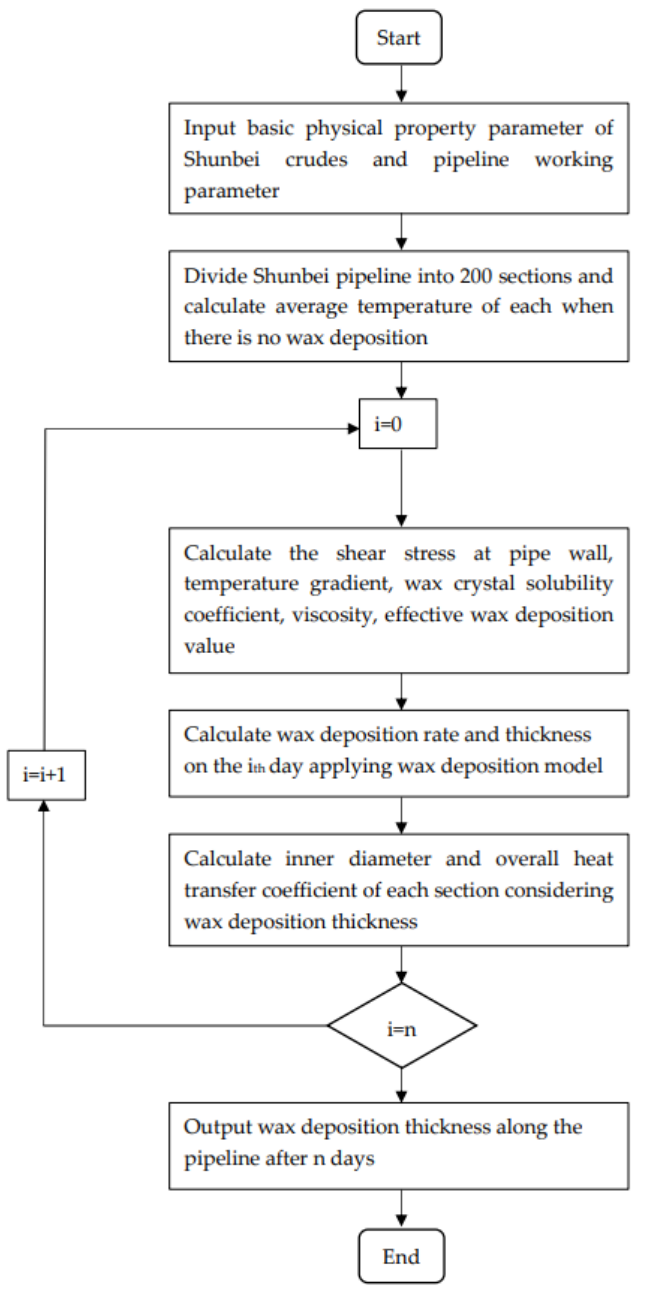
Figure 8. Program flow chart of wax deposition calculation.